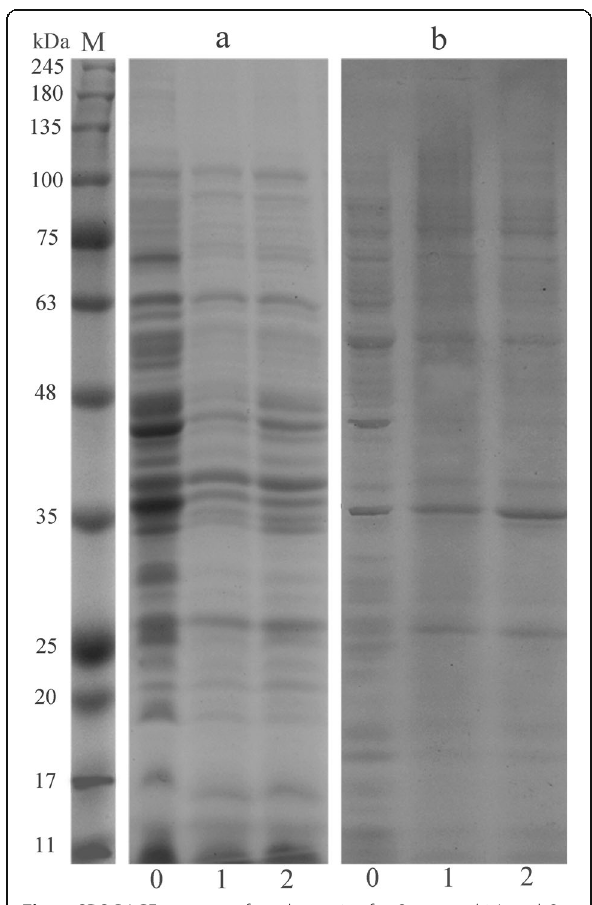
Fig. 5 SDS-PAGE patterns of total proteins for S. paratyphi A and S.